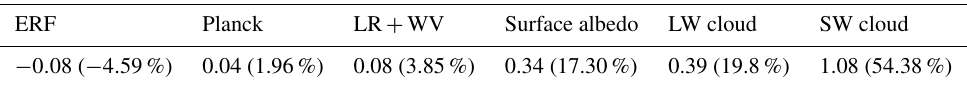
Table 1. Contributions of each component in the forcing-feedback framework to CanESM5’s increased EffCS (in kelvin). Individual contri- butions from feedbacks were calculated by substituting feedback values from CanESM5 into CanESM2 and recalculating EffCS and then taking the difference between CanESM5’s EffCS and the recalculated EffCS. Relative contributions (given in parentheses) are defined as the percentage of each value of the difference between CanESM5 and CanESM2s EffCS (1.98K). This process was repeated for all individual feedbacks and the ERF. ERF Planck LR + WV Surface albedo LW